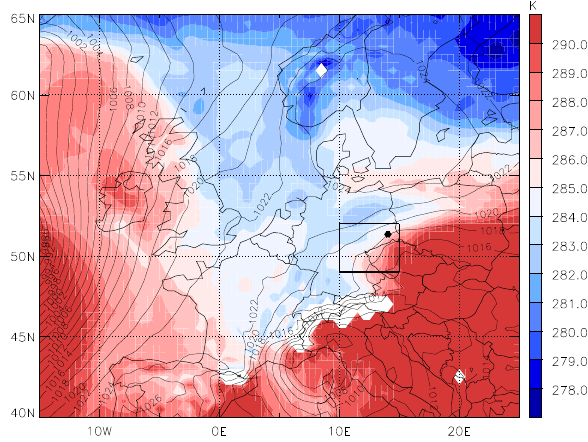
Fig. 4. ECMWF analysis fields at 12 UTC 16 November 2010. Shown is sea-level pressure (black contours, every 2hPa) and po- tential temperature at 850hPa (colors, in K). The black dot marks Dresden and the black rectangle the area shown in Figure 5.